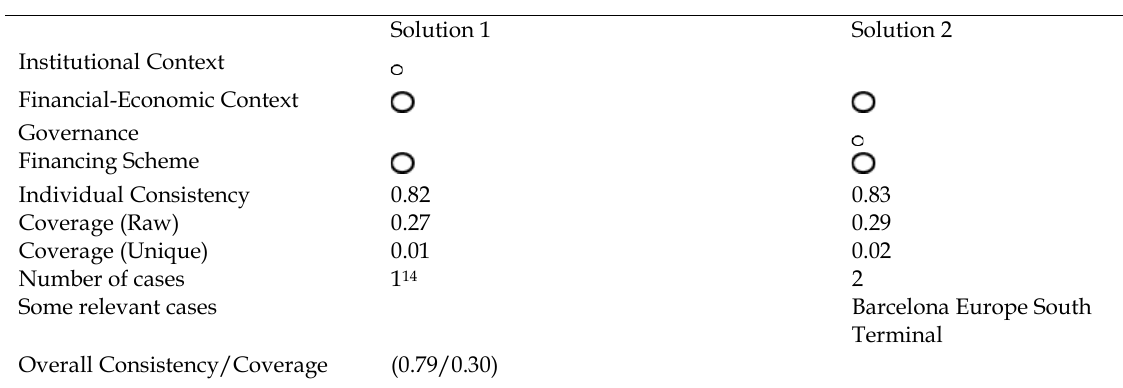
Sufficiency analysis of projects being over cost - simplified (cut-off: 0.82) OUTCOME: absence of